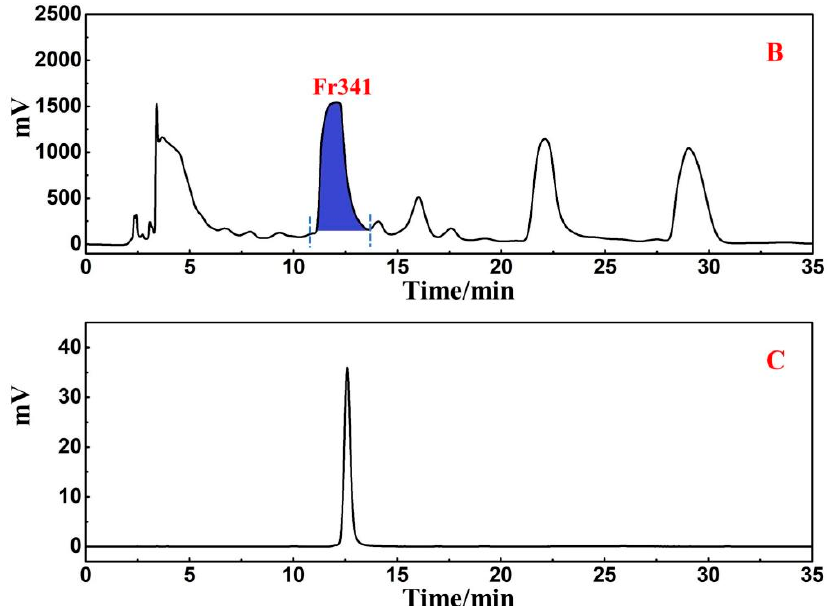
Figure 3. ( A )The analytical chromatogram of fraction Fr34 on the ReproSil-Pur C18 AQ. ( B ) High- pressure preparative fraction Fr34 chromatogram using a ReproSil-Pur C18 AQ preparative column. ( C ) The analytical chromatogram of fraction Fr341 on the ReproSil-Pur C18 AQ.